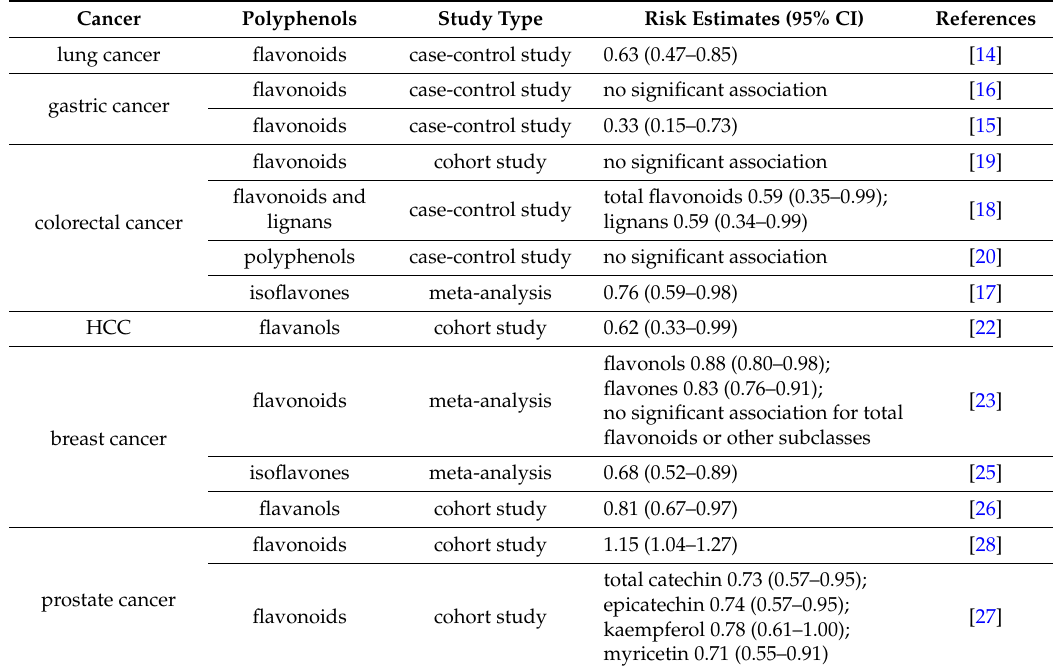
Table 2. Dietary polyphenol intake and cancer risks.